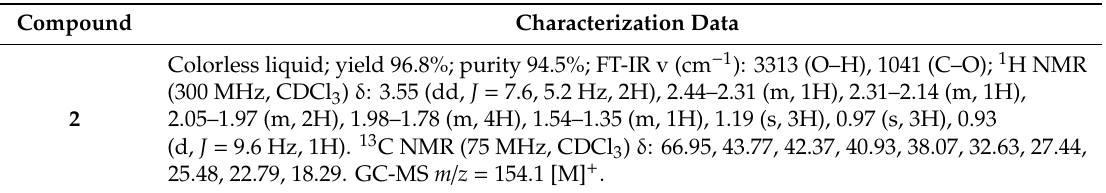
Table 2. Characterization data of myrtanol.